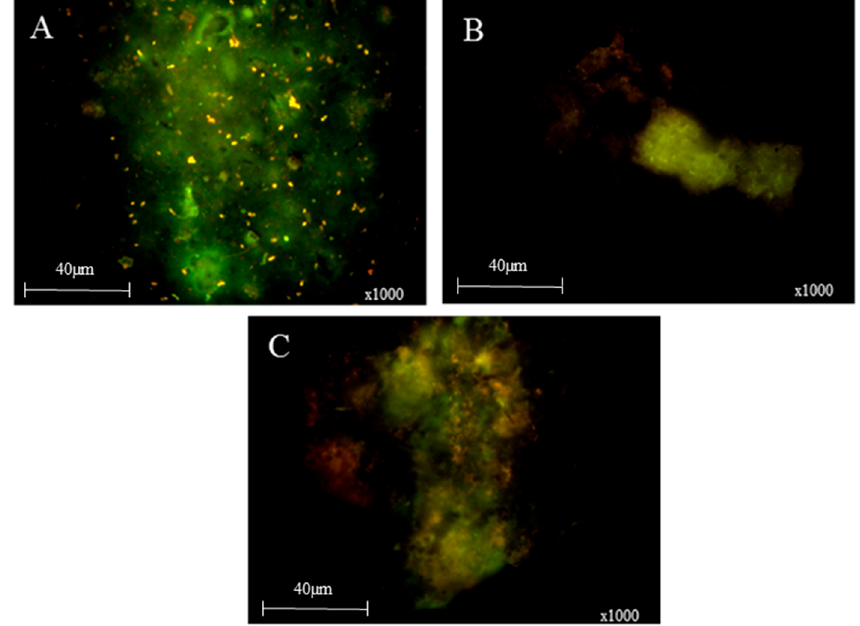
Figure 2 . Multispecies flocs survived transit across the NRVB surface. Live/dead staining of the microbial flocs leaving the NRVB columns at ( A ) pH 11, ( B ) pH 12, and ( C ) pH 13 indicated that the flocs were able to survive transit across the surface of the NRVB.